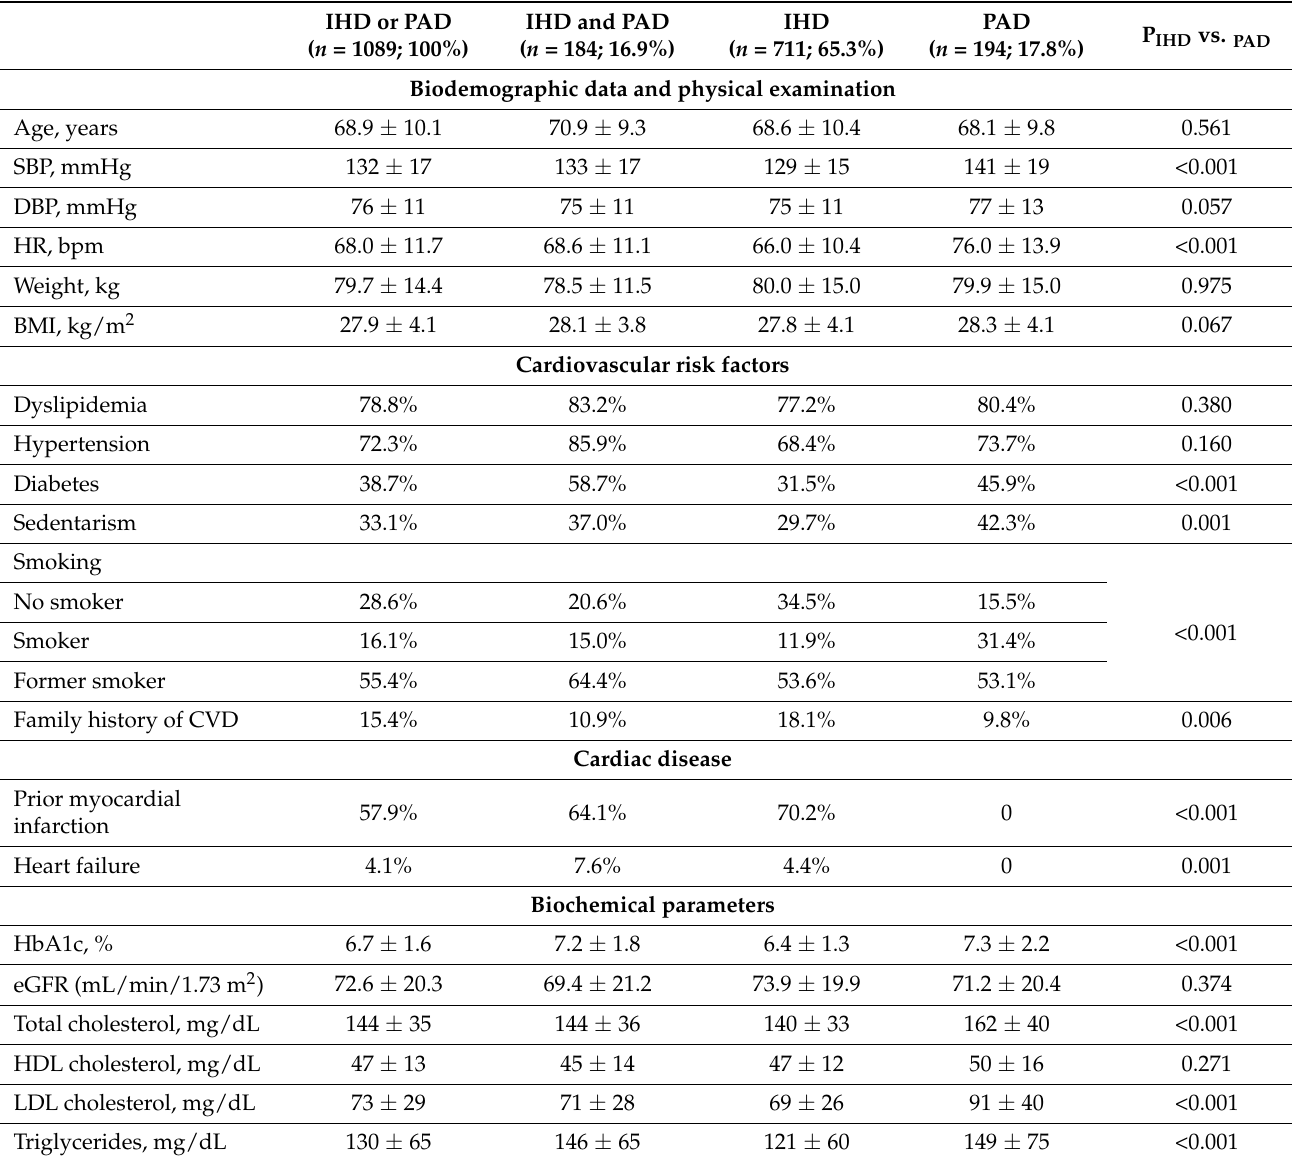
Table 2. Baseline clinical